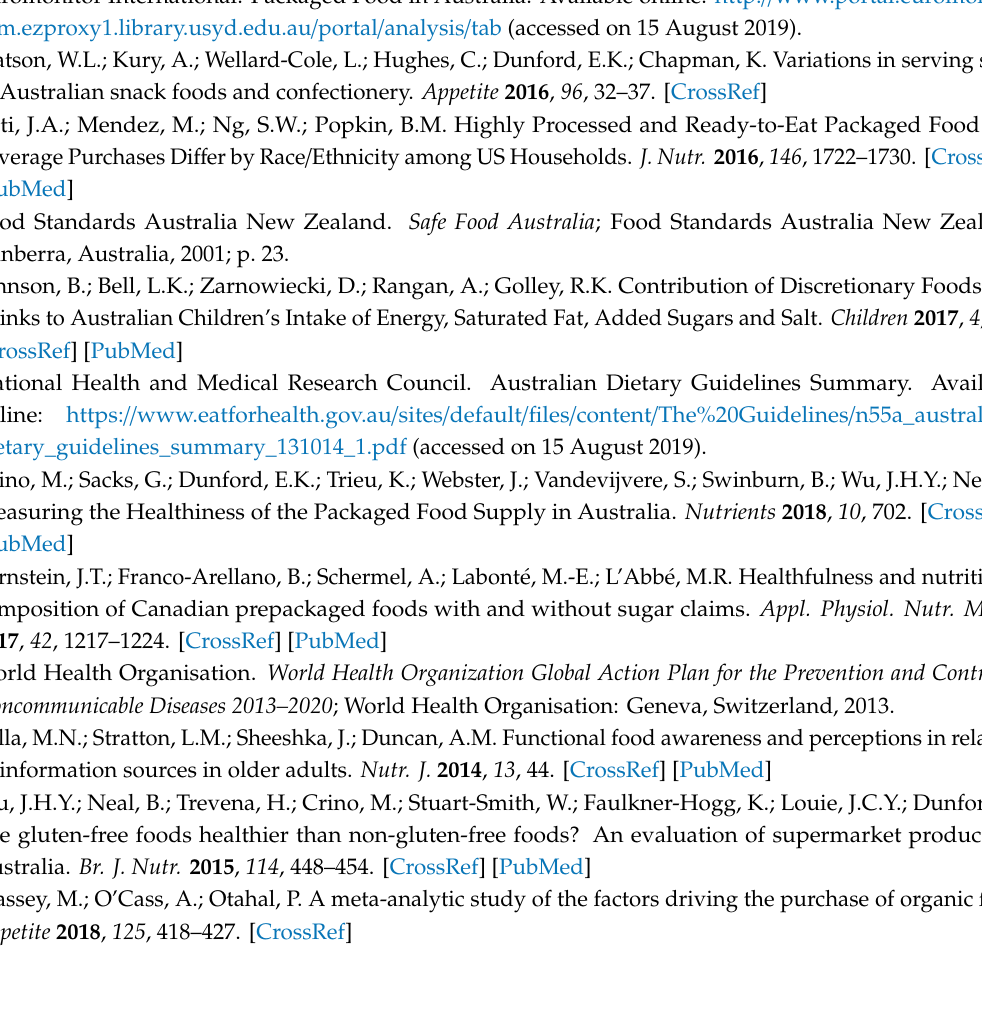
Table S1. Product category and subcategory descriptions. Table S2. Product claim categories. Table S3. Comparative analysis of median unit cost ($ / 100g) between health food (HF) snack products sold in supermarkets and specialty HF stores compared to equivalent products sold in regular aisles (RA) of